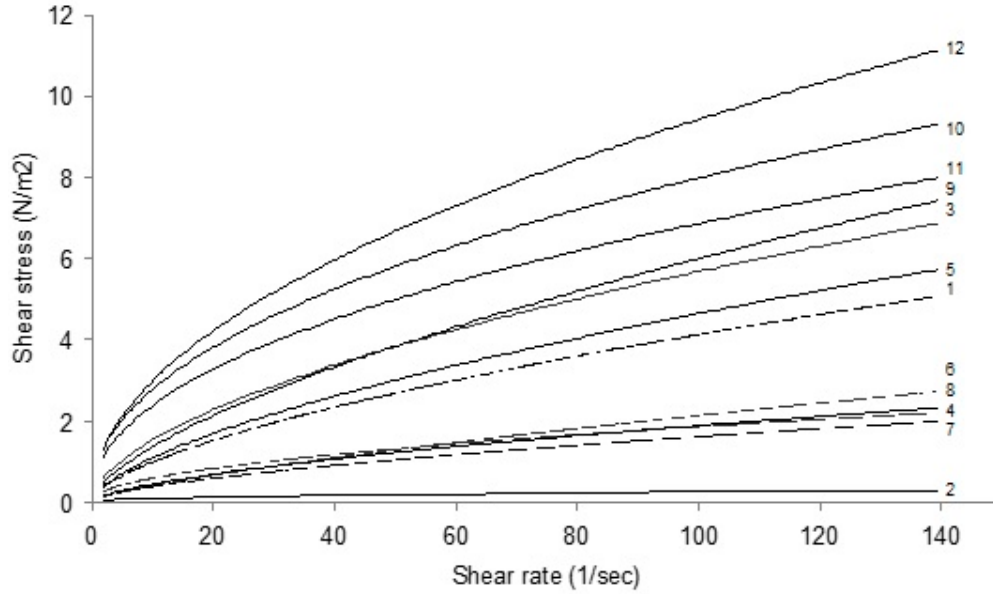
Figure 1. Shear stress versus shear rate of twelve licorice extract solutions with the degrees Brix of 30 (sample numbers 1 to 12) at 60 °C.